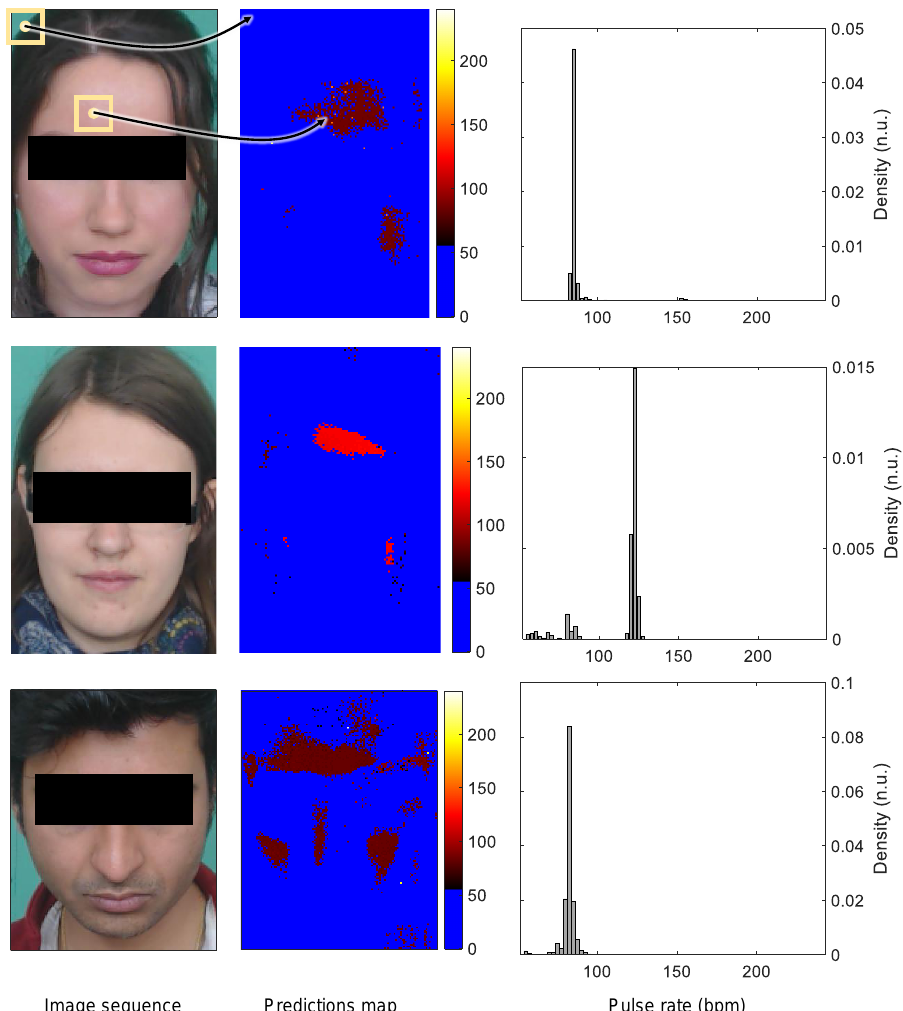
Figure 8. Maps of predictions and their relative histograms. The model produces a prediction for each group of 25 × 25 pixels in the video stream. Blue pixels correspond to regions where no distinct PPG variations were identified, while the other colors refer to properly predicted pulse rate values. Top row: data and results for subject #1 (first 60 frames; histogram main peak: 85 bpm; ground truth: 90 bpm). Middle row: data and results for subject #33 (first 60 frames; histogram main peak: 122.5 bpm; ground truth: 122 bpm). Bottom row: data and results for subject #42 (first 60 frames; histogram main peak: 82.5 bpm; ground truth: 81